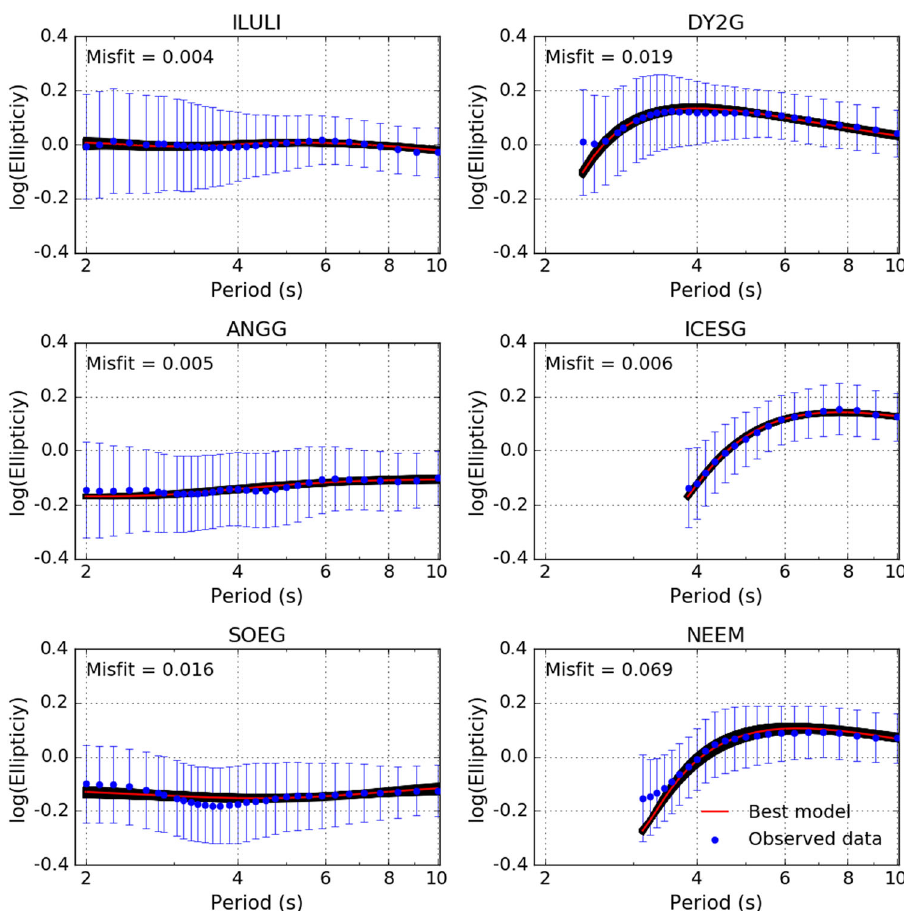
Fig. 5 Comparison of ellipticity measurements and fundamental mode predictions from the best- fi tting V s models for illustrative off- (left column) and on-ice (right column) stations. The measured ellipticity (blue dots), standard deviation (error bars), predictions for the models within the uncertainty range (black lines) and the minimum mis fi t model (red line) are all